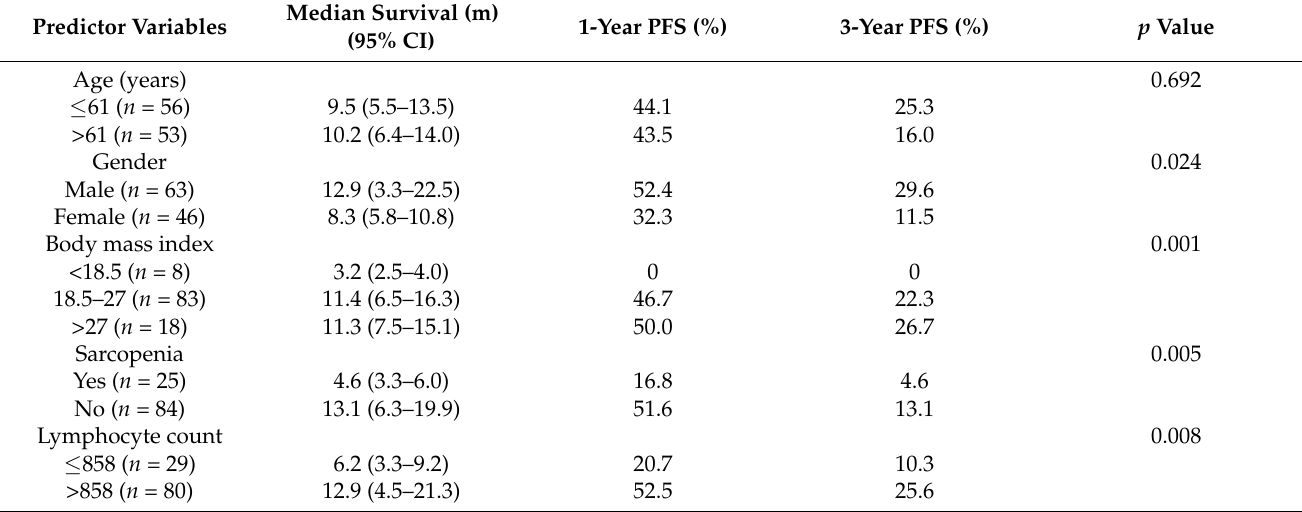
Table 2. Progression-free survival analysis of each predictor variable (Univariate).